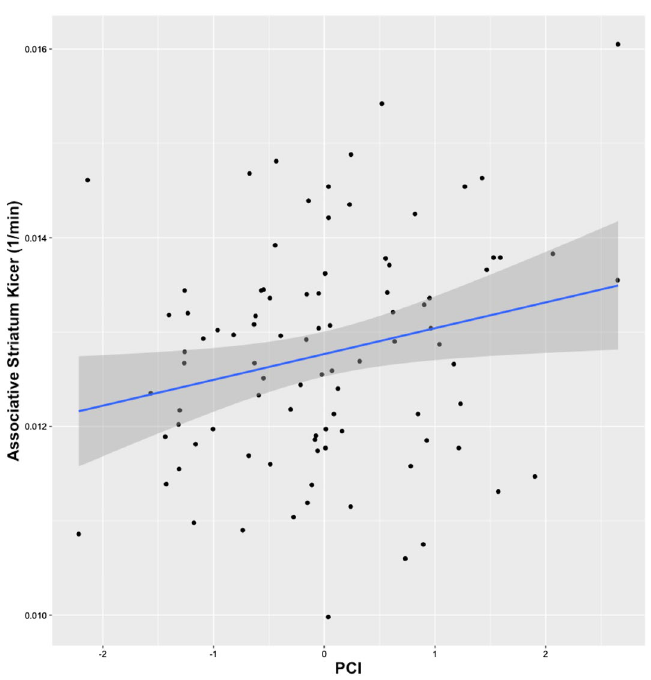
Figure 2. Scatterplot illustrating the correlation between associative striatum K icer (y axis) and